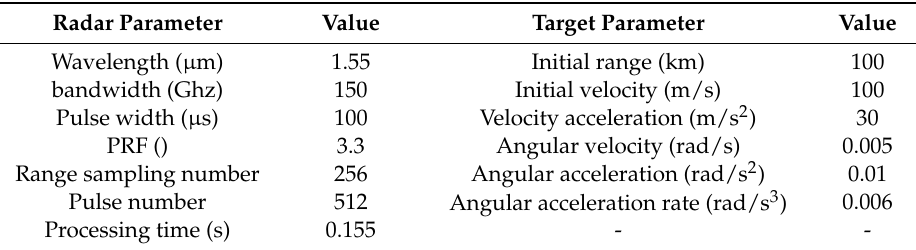
Table 1. Simulation